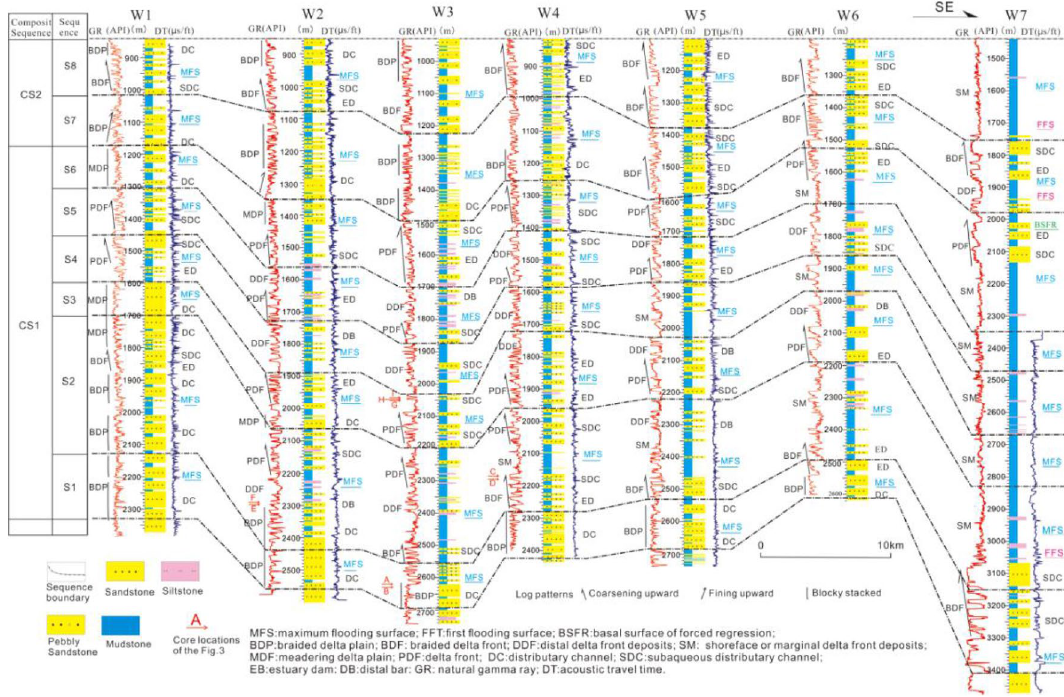
Figure 5. Well log correlation of depositional facies of sequences S1–S8. Note the transition from the braided river delta deposits at the bottom to the meandering river delta deposits and the transition from the delta plain deposits in the northwest to the pre-delta/slope deposits in the southeast at the uppermost region of the study area (location of the log correlation shown in Fig. 1b). The braided river deltiac systems (S1–S2) are characterized by thick bedded of pebbly coarse grained distributary channel deposits in the delta plain and subaqueous distributary channel deposits in the delta front. The meandering river delta systems (S3–S8) exhibit thin or no delta plain deposits and a middle-thick bed of middle-fine sandstone in the estuary dam deposits in the delta front. The location of the cores are shown in the W2, W3, W4 and W5 boreholes.